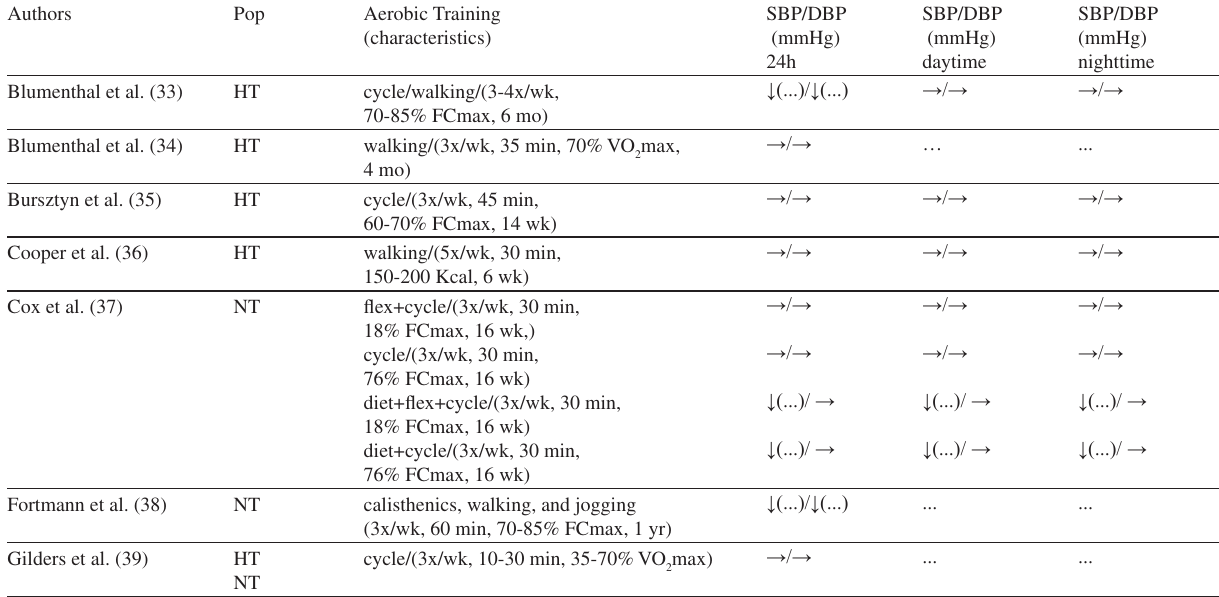
Table 2 - Effects of aerobic training on ambulatory blood pressure